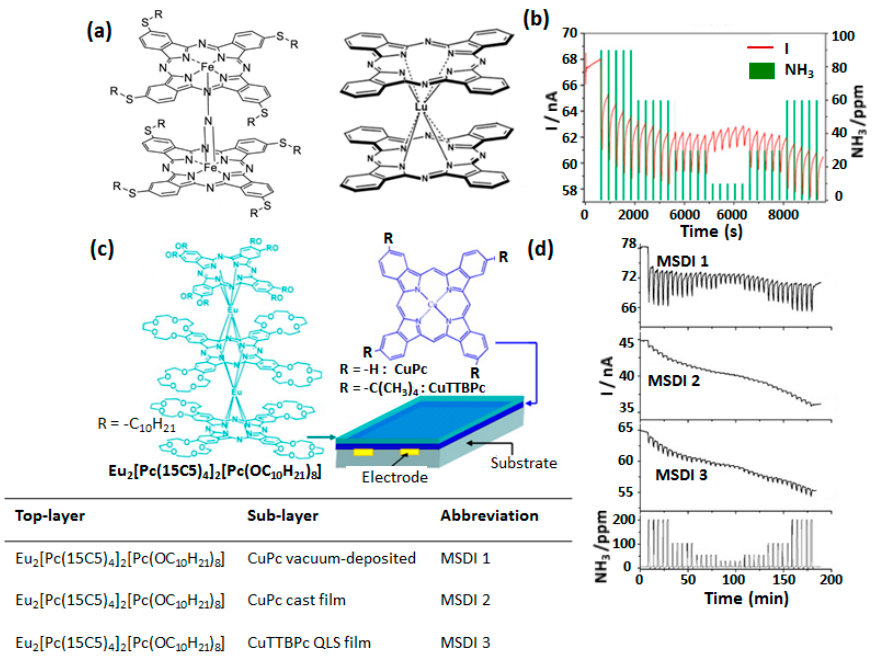
Figure 12. Structure of alkylthio-tetrasubstituted µ -nitrido diiron phthalocyanines and LuPc 2 ( a ) and NH 3 sensing performance of related MSDI studied in a range of 10–90 ppm ( b ) [72]. Structure of triple-decker phthalocyanine Eu complex and substituted CuPc and related MSDI device ( c ). Current-time response curves of different MSDI recorded with alternate exposure to NH 3 in a concentration range 50–200 ppm and recovery under clean air ( d ) [73].